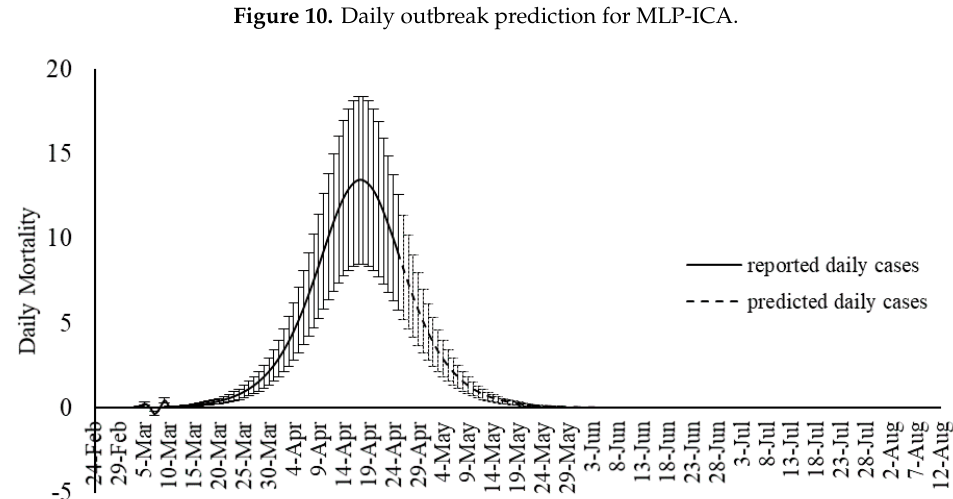
Figure 11. Daily mortality rate prediction for MLP-ICA.